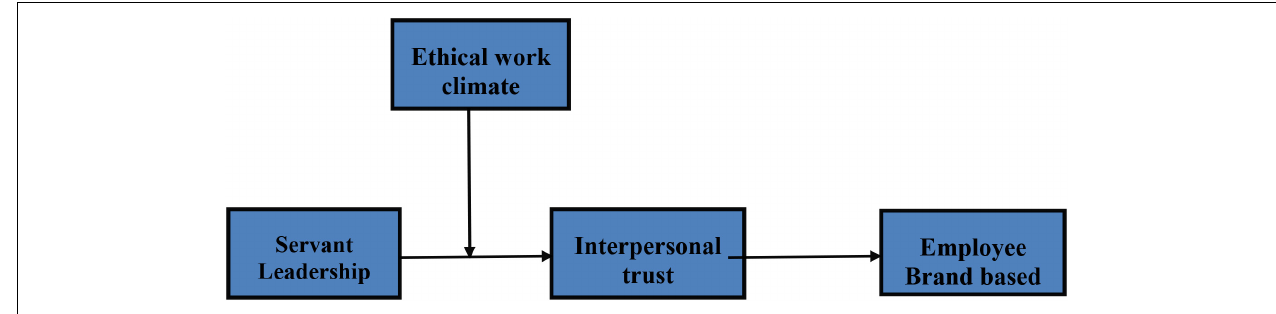
FIGURE 1 | Conceptual